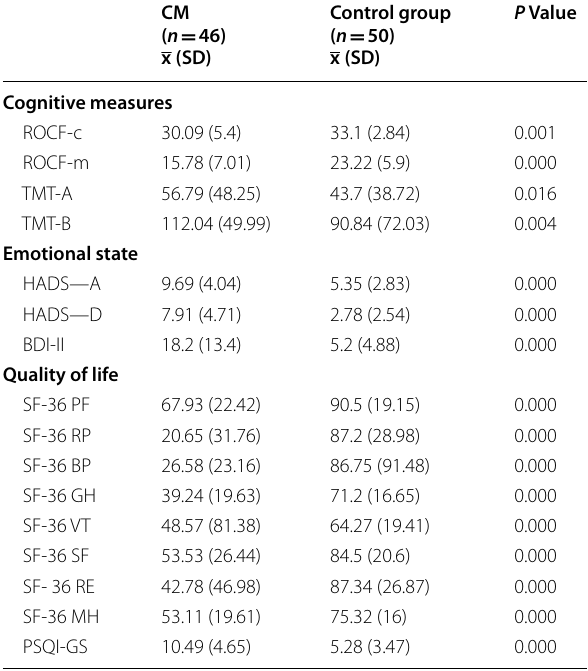
Table 2 Comparison between the CM group ( n control group ( n 50) in the cognition and quality of life scales = used at